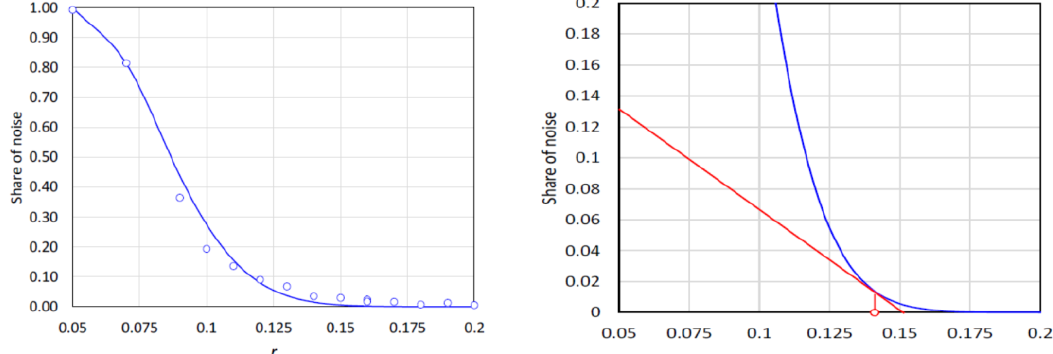
Figure 5. Determination of the value of r . ( a ) The results obtained with multiple clustering of a ran-dom sample with different radius values. ( b ) The dependence of the proportion of discarded elements on the radius Algorithm 1. Clustering by the DBSCAN